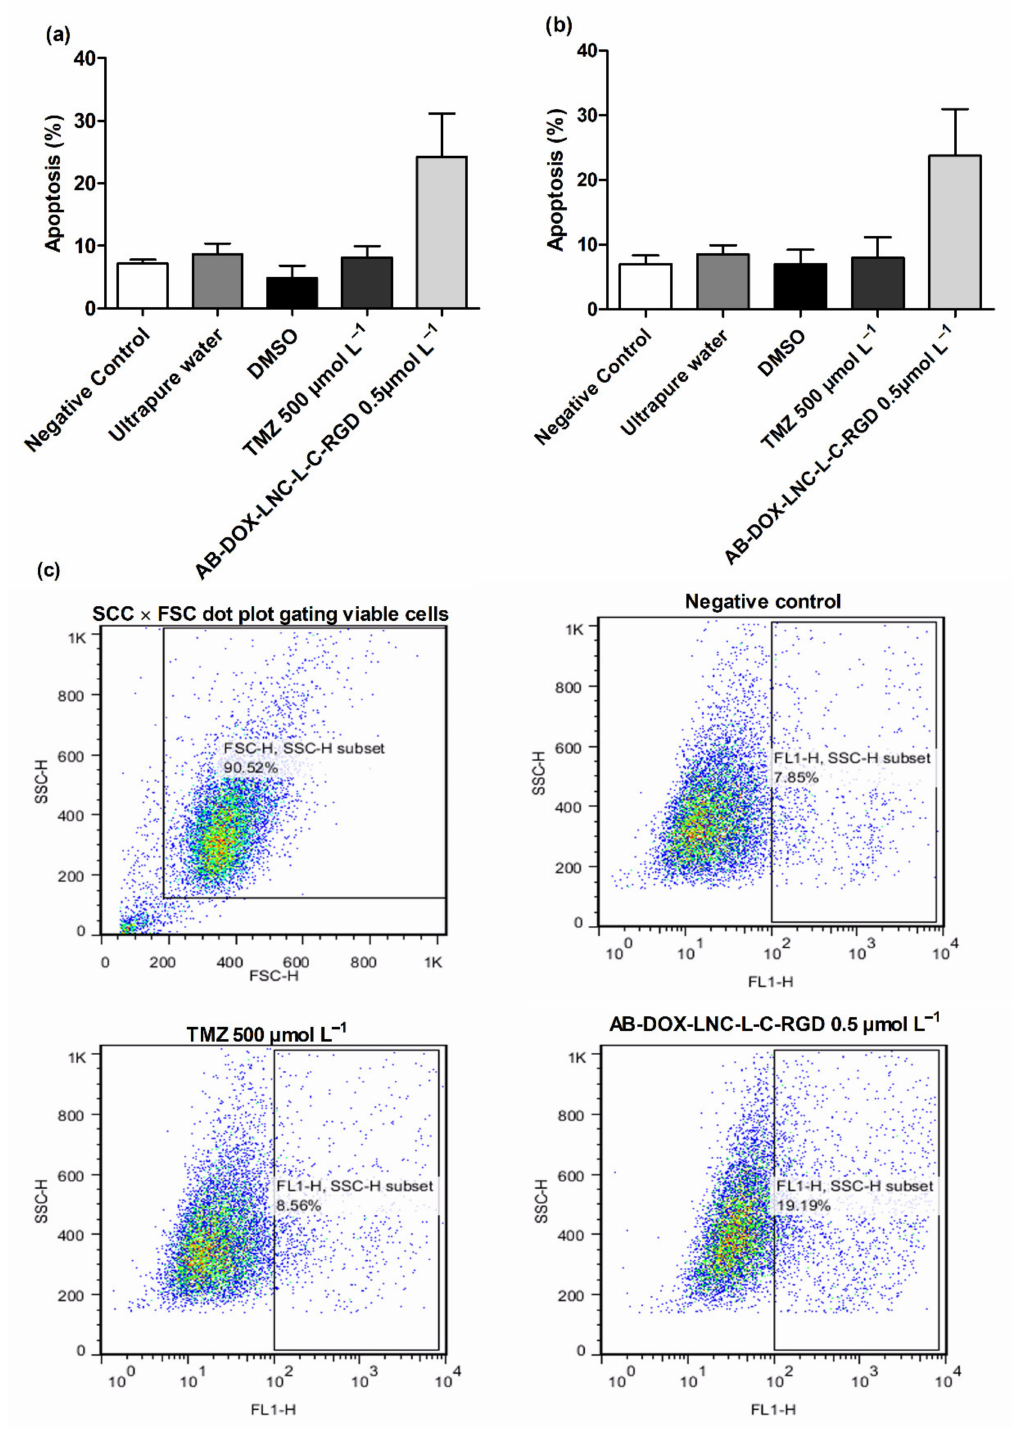
Figure 4. Apoptosis after 24 h of treatment for ( a ) U87MG cell line, ( b ) U138MG cell line, and ( c ) representative dot plots for U87MG cell line. Data are expressed as the mean ± SEM ( n = 3). Negative control (untreated cells-control 1), ultrapure water (control 2), DMSO (control